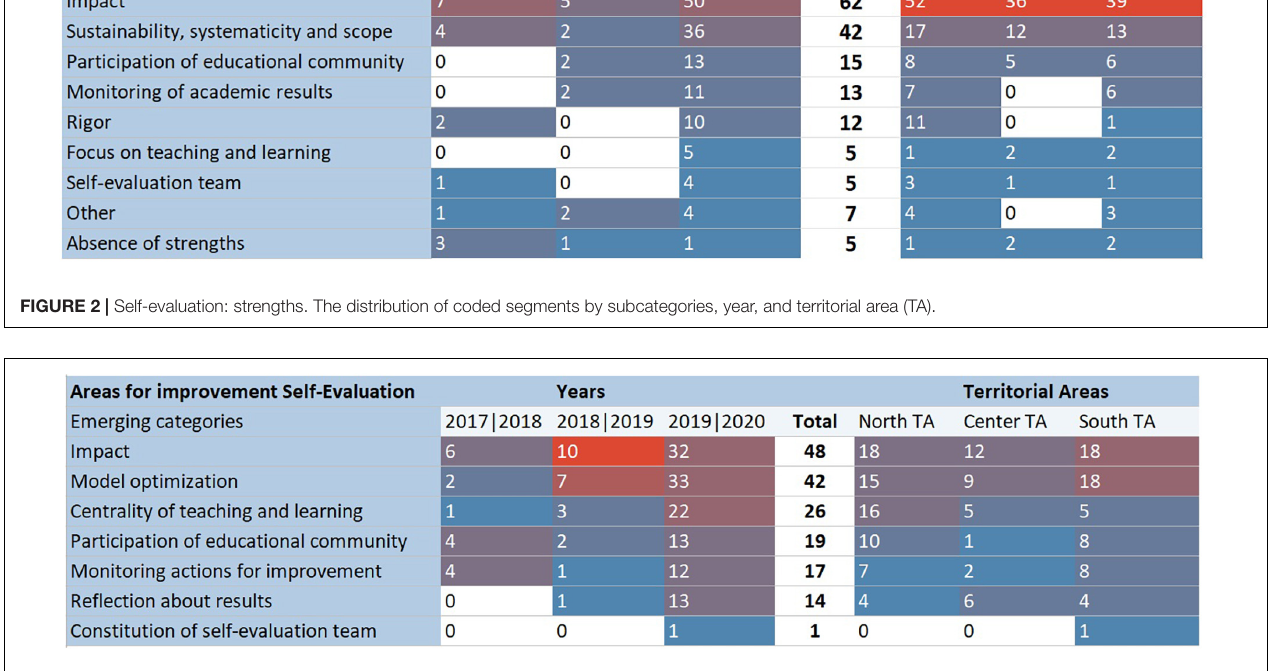
FIGURE 3 | Self-evaluation: areas for improvement. The distribution of coded segments by subcategories, year, and